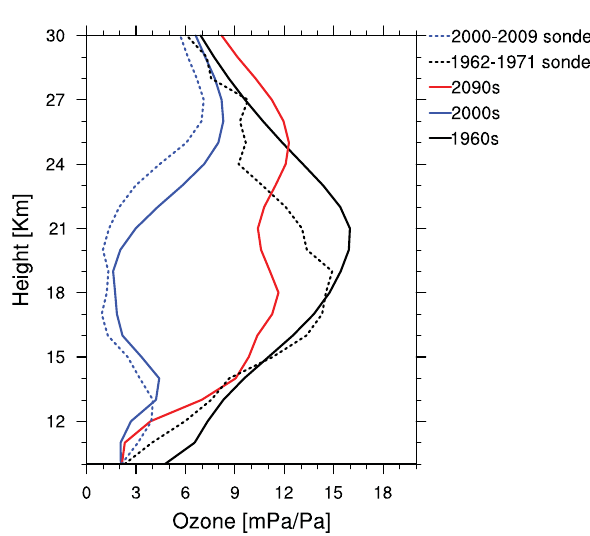
Fig. 14. October mean vertical ozone profiles from the AC&C/SPARC ozone database over the South Pole for the 1960s, 2000s and 2090s (black, blue, and red solid lines, respectively) com- pared to ozonesondes for the 1960s (1962–1971, black dashed line) and the recent past (2000–2009, blue dashed line). The future GHG scenario shown is RCP 4.5 in the troposphere and SRES A1B in the